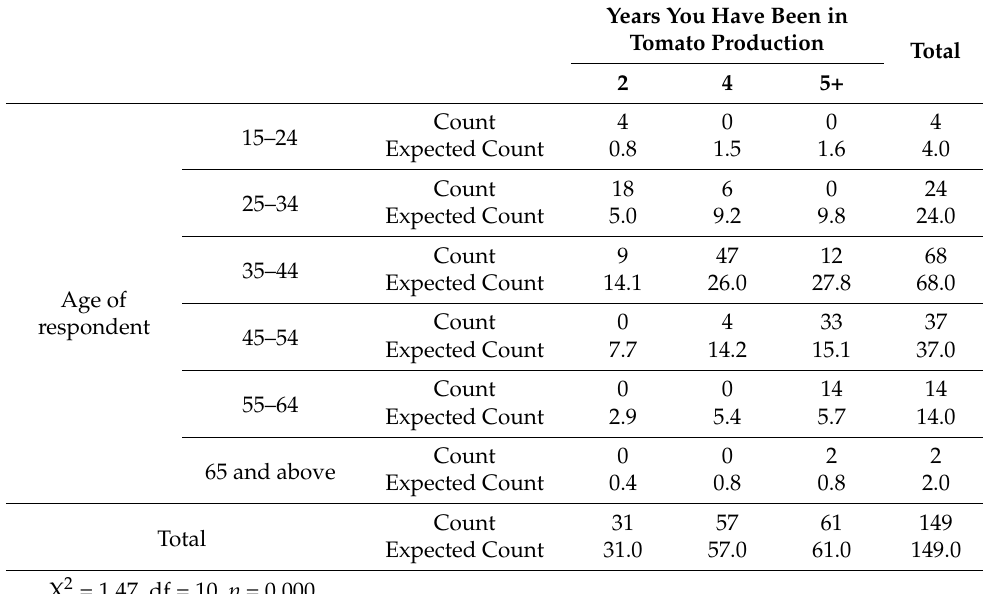
Table 7. Farmers’ age in years. Tomato farming experience in years